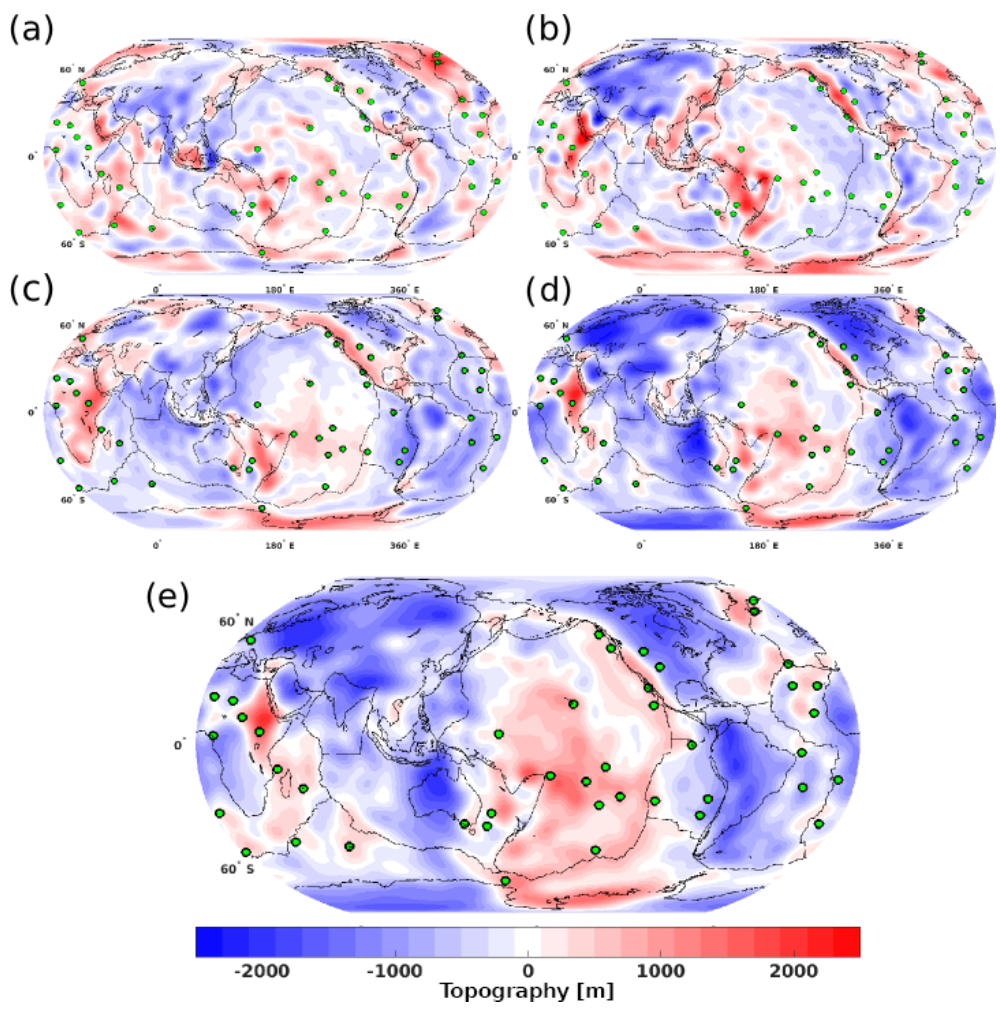
Figure 9. Comparing (a) the in situ observed residual topography from Hoggard et al. (2016), and (b) the residual topography based on the CRUST 1.0 from Steinberger (2016) with modeled dynamic topography using TM1 (c) and TM2 (d) upper mantle thermal density structures with the effect of seafloor cooling with age removed. (e) Similar modeled dynamic topography using TM2 upper mantle thermal density structures with constant temperature (300K) added in cratons. Green dots with black circles around them show locations of major hotspots (Steinberger,